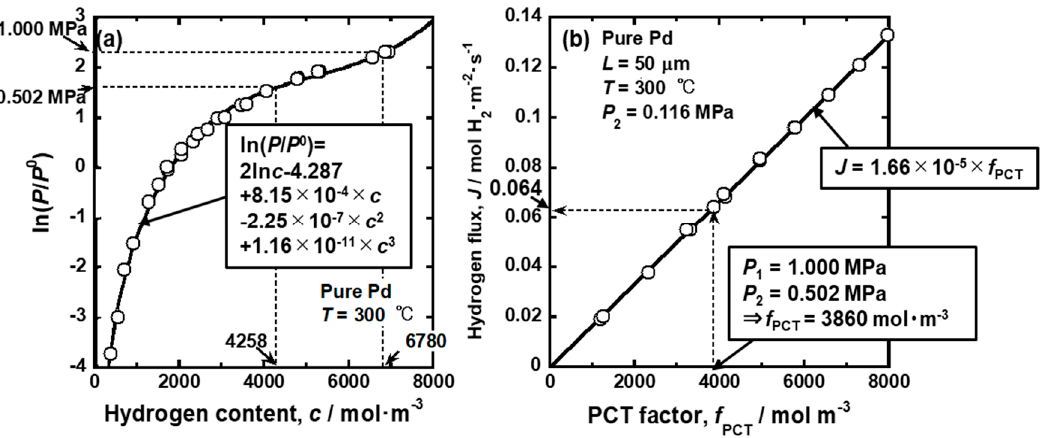
Figure 5. Changes in ( a ) the hydrogen flux and ( b ) the pressure-dependent hydrogen permeation coefficient for pure Pd membrane as a function of the square root of hydrogen pressure at the feed side [15].